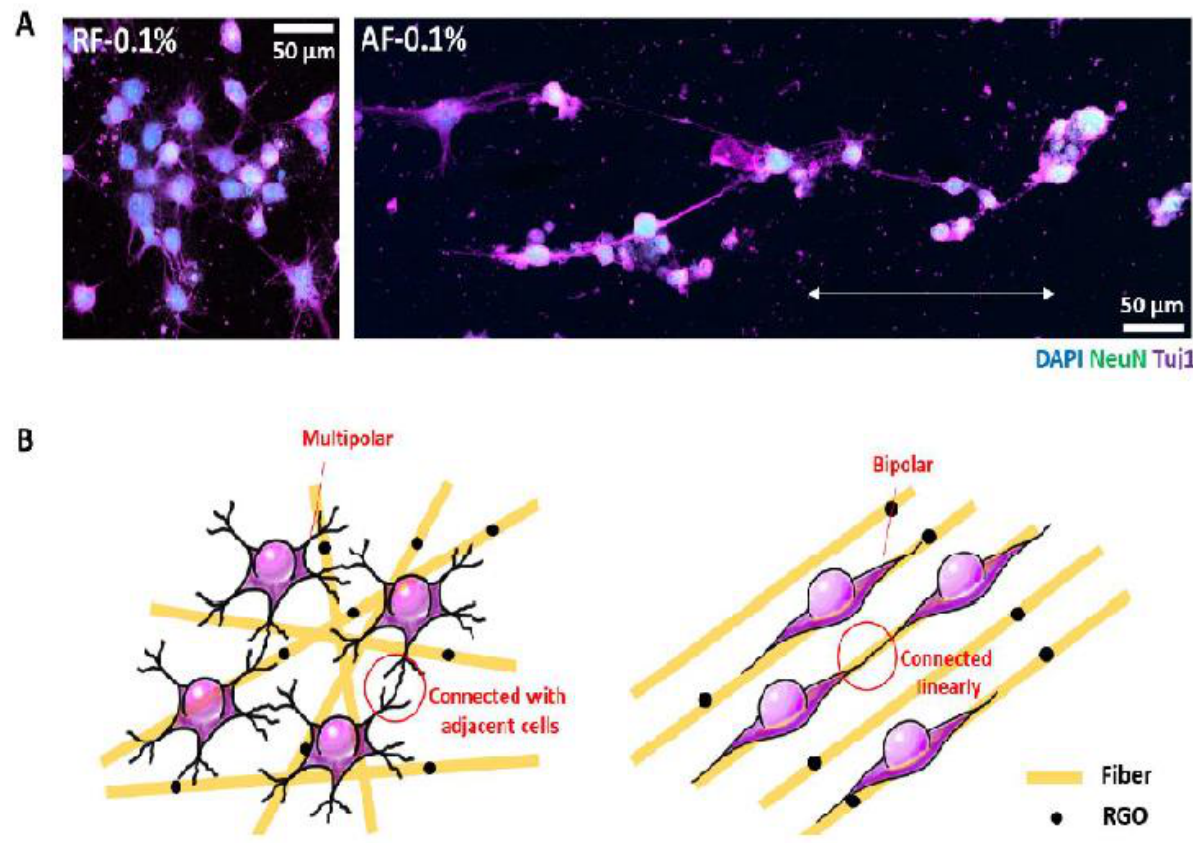
Figure 7. The effect of RGOPCL NF comparison on the differentiation of DPSC. Compare neurites ( A ). The neurites differentiated from 0.1% of RF cells are combined with adjacent cells, but the differentiated neurites of the AF0.1% spread and connect in the direction of the AF arrangement. ( B ) The ideas of RF0.1 in research will be used to create a multi- directional neural network because it can connect differentiated cells with neighboring cells. However, because it can align and link differentiated cells in the direction of AF alignment, AF0.1% can be used to generate unidirectional neural networks[83].